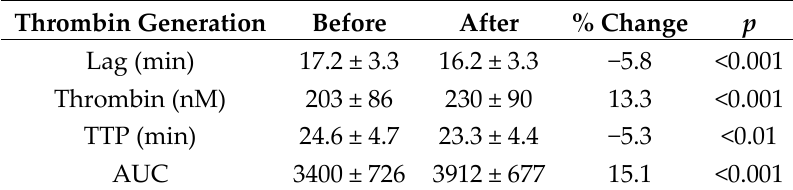
Table 1. Thrombin generation before and after the “in vitro” addition of idarucizumab to normal plasma samples. Means ± standard deviations are shown with paired T -Test p